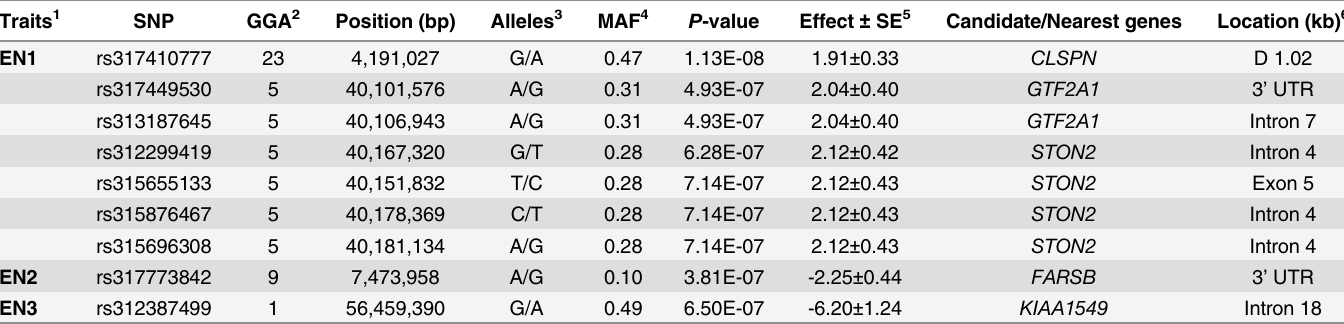
Table 4. The information for SNPs significantly associated with egg number in the five laying stages. Traits